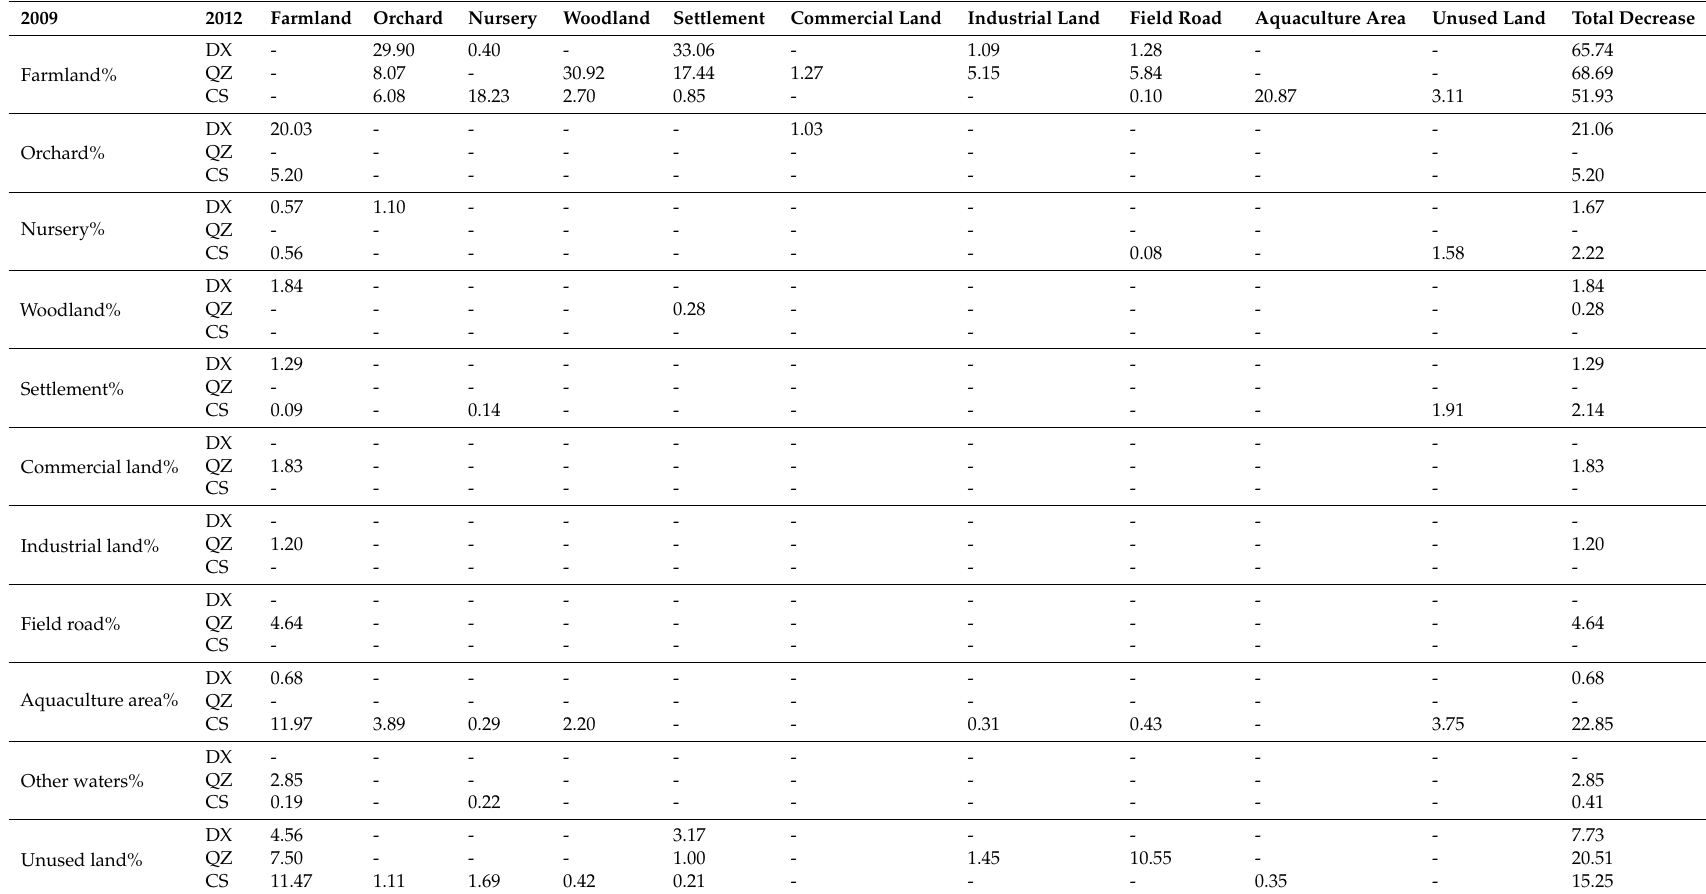
Table 3. Land use transformation